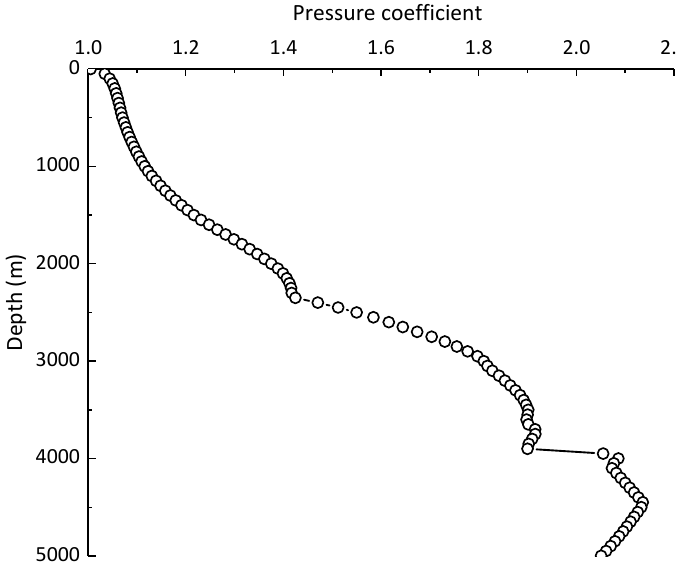
Figure 11. Prediction of the undrilled pore pressure profile.